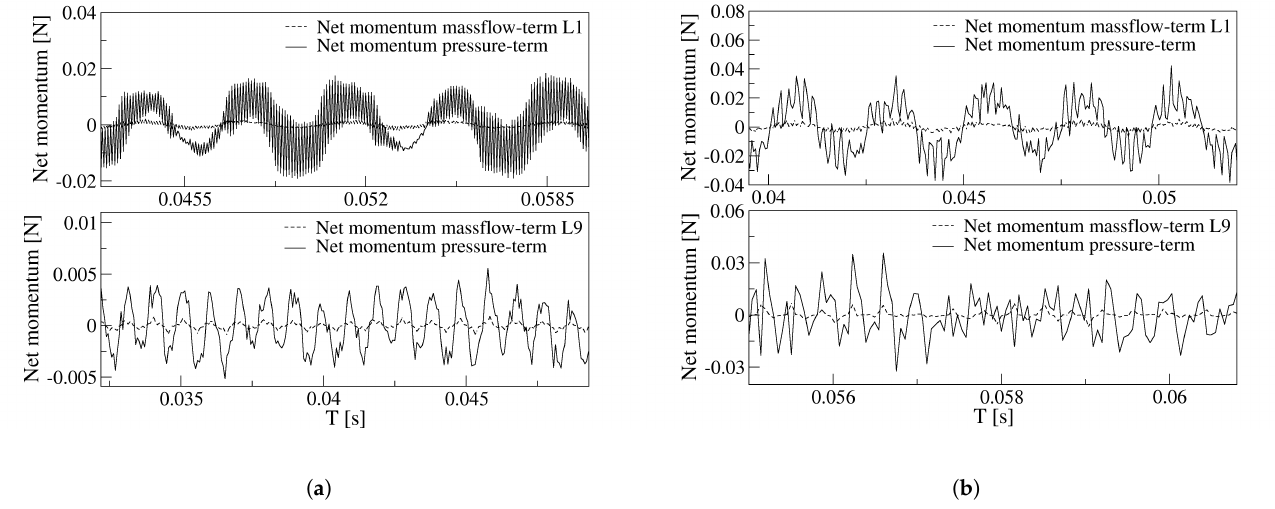
Figure 14. Comparison of the net momentum pressure term with the mass flow term, for the baseline case L1, and for the maximum (FC) length L9. ( a ) Power nozzle velocity, 65 m/s. ( b ) Power nozzle velocity, 97